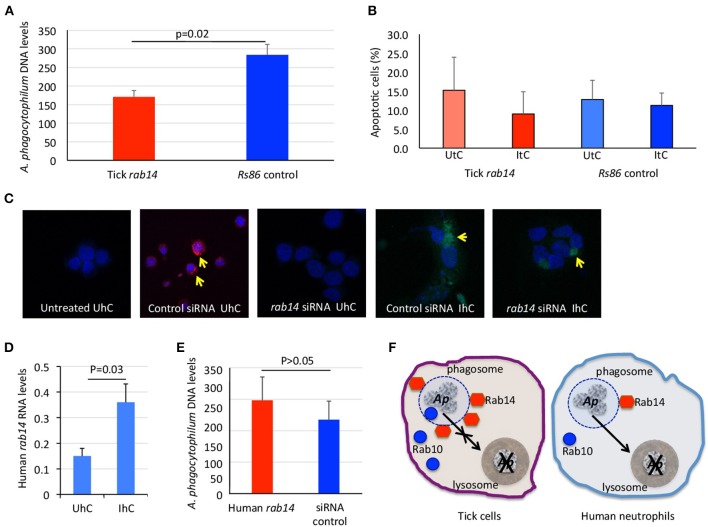
Functional analysis by RNAi supports a role for tick and human Rab14 in A. phagocytophilum infection of host cells. (A) A 75–83% knockdown by RNAi of tick rab14 (B7QHS7) in tick cells resulted in a 40% decrease in A. phagocytophilum infection levels, suggesting that A. phagocytophilum increases the levels of Rab14 to facilitate infection. Tick ISE6 cells were treated with rab14 dsRNA and control cells were treated with the unrelated Rs86 dsRNA. DNA samples from infected cells were analyzed by real-time PCR using the A. phagocytophilum major surface protein 4 (msp4) gene-specific primers. Normalized Ct values were compared between groups by Student's t-test with unequal variance (p = 0.02; n = 6 biological replicates). (B) Tick rab14 knockdown did not affect cell viability. The percent of apoptotic tick ISE6 cells was determined after RNAi with rab14 test and Rs86 control dsRNAs by flow cytometry using the Annexin V-fluorescein isothiocyanate (FITC) apoptosis detection kit. The percentage of apoptotic cells was compared between both test and control dsRNA treated UtC and ItC by Student's t-test with unequal variance (p > 0.05; n = 6 biological replicates). (C) Representative images of immunofluorescence analysis of UhC and IhC incubated with either ON-TARGETplus SMARTpool Human rab14 siRNA or control ON-TARGETplus Non-targeting Control Pool siRNA. Cells were stained with rabbit anti-A. phagocytophilum msp4 antibodies, labeled with FITC (green, arrows) and DAPI (blue). To confirm the uptake of siRNA, cells were treated with Accell Red Non-targeting Control siRNA (red, arrows) and labeled with DAPI (blue). (D) Human rab14 was up-regulated at the mRNA level in response to infection. The RNA levels of human rab14 (P61106) were determined by real-time RT-PCR in UhC and IhC. Normalized Ct values were compared between groups by Student's t-test with unequal variance (p = 0.03; n = 4 biological replicates). (E) A 31–52% knockdown by RNAi of rab14 in human HL60 cells did not affect A. phagocytophilum infection levels, suggesting that Rab14 protein levels decrease post-transcriptionally in human neutrophils to control A. phagocytophilum infection. Human HL60 cells were treated with rab14 siRNA or control ON-TARGETplus Non-targeting Control Pool siRNA. DNA samples from infected cells were analyzed by real-time PCR using the A. phagocytophilum major surface protein 4 (msp4) gene-specific primers. Normalized Ct values were compared between groups by Student's t-test with unequal variance (non-significant, p > 0.05; n = 4 biological replicates). (F) Proposed model of ras-related protein function in A. phagocytophilum-infected tick and human cells. In tick cells, A. phagocytophilum (Ap) increases the levels of active ras-related proteins Rab14 in phagosomal membranes to prevent the transfer of bacteria from phagosomes to lysosomes and hijacks Rab10 and other endoplasmic reticulum membrane proteins to its vacuole to complete the infection cycle and favor pathogen survival and facilitate infection. In human neutrophils, the decrease in Rab10 levels appears as a post-transcriptional mechanism to control A. phagocytophilum infection.